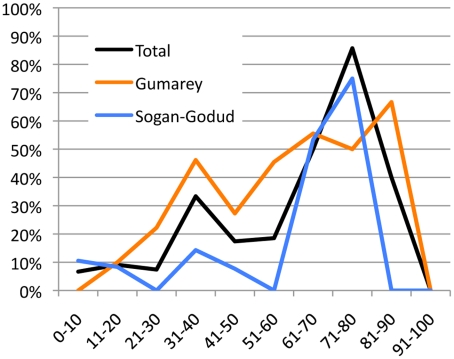
Seroprevalence of age groups from study villages and total sample.